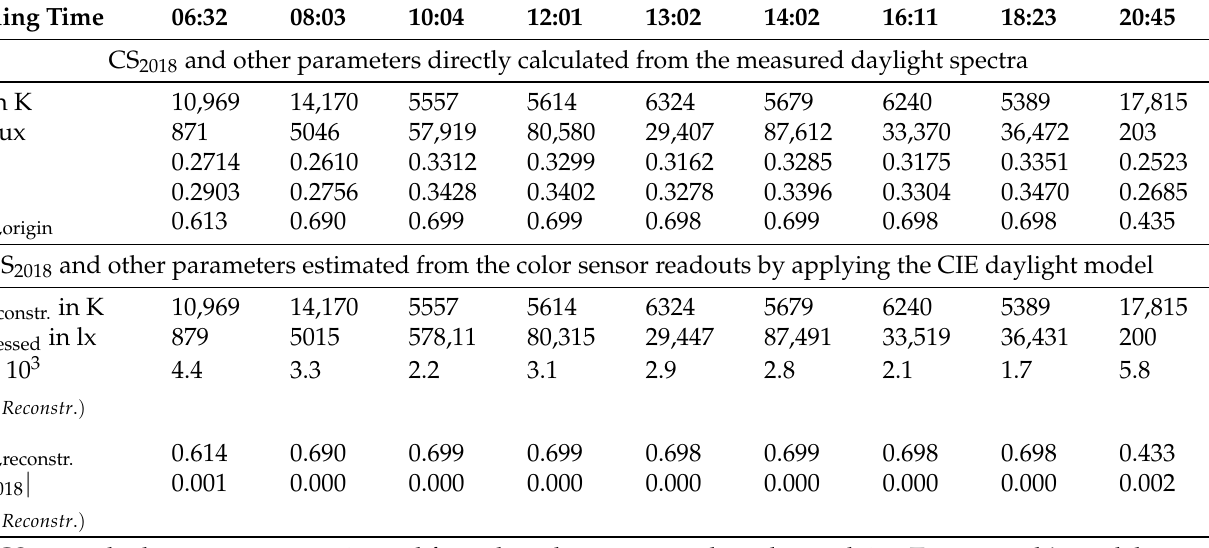
Table 6. Comparison between the color sensor’s CS predictions (CS 2018,reconstr. ) and Rea et al.’s original model (CS 2018,origin ) for a representative selection of daylight spectra from the respective training dataset. The measurement uncertainty for CS 2018,origin is of the order of ± 8%. Additionally tabulated are the final 3 × 3 daylight-specific transformation matrix, as well as the corresponding functional relationship between the illuminance and the sensor’s green channel output G i . Here, the annotation “ ( Meas . − Reconstr . ) ” indicates that the given accuracy estimates | ∆ CS 2018 | and colori- metric prediction errors ∆ u (cid:48) v (cid:48) are determined by comparing the corresponding quantities derived from the performed radiometric measurements (i.e., “ Meas .”) and the application of Rea et al.’s model formalism to those obtained by processing the sensor readouts for the subsequent application of the CIE daylight reconstruction method (i.e., “ Reconstr .”) as proposed in this work. The annotation “ ( Meas . − Calc . ) ”, on the other hand, again denotes the use of Truong et al.’s approximation method also for daylight